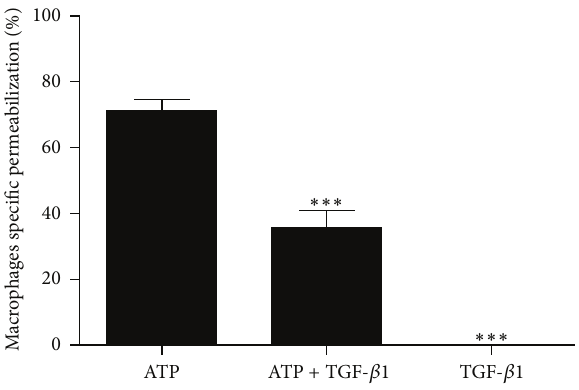
Figure 4: ATP-induced permeabilization assays (based on ethidium bromide uptake) by peritoneal F4/80 positive macrophages of uninfected mice treated with TGF- 𝛽 1. Cells treated with 5 ng/mL TGF- 𝛽 1 or vehicle for 24 h were stimulated with 1mM ATP. ATP- induced permeabilization values represent the % of EB uptake above basal levels and were expressed as mean and SEM. 𝑛 = 8 – 21 replicates using 6 animals ( ∗∗∗ 𝑃 < 0.001 versus ATP, one-way ANOVA followed by post hoc Newman-Keuls